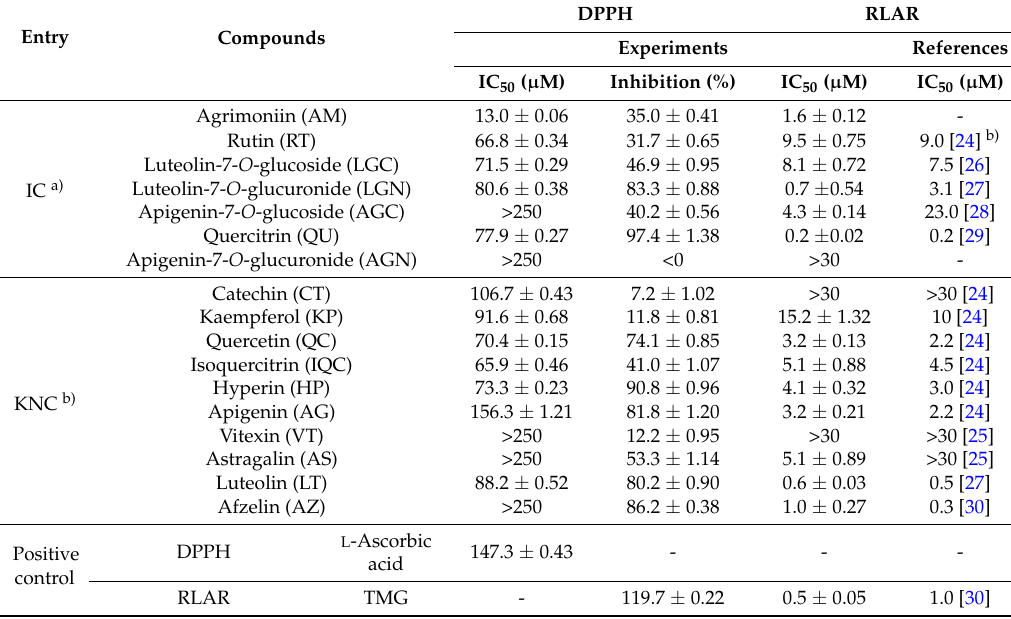
Table 2. Inhibitory effect of compounds referenced and isolated from A. pilosa Ledeb. on rat lens aldose reductase (RLAR) and DPPH free radical scavenging